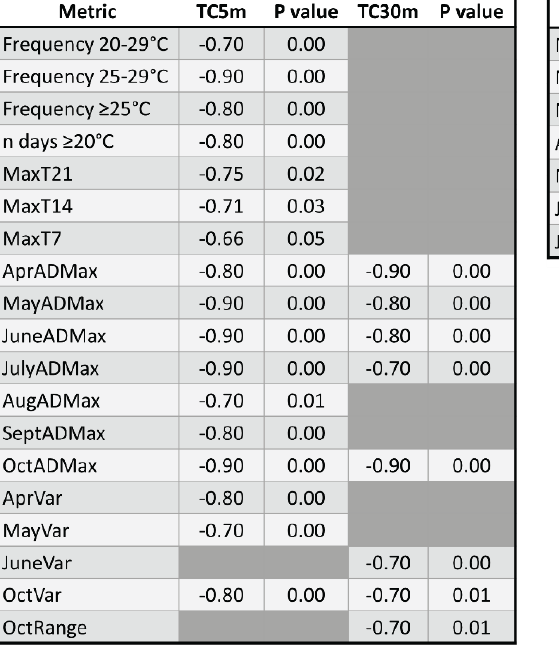
Figure 4. Significant Pearson correlations between water temperature metrics and percent tree can- opy within 5 m riparian areas (TC5m) and 30 m riparian areas (TC30m). within 5 m riparian areas (TC5m) and 30 m riparian areas